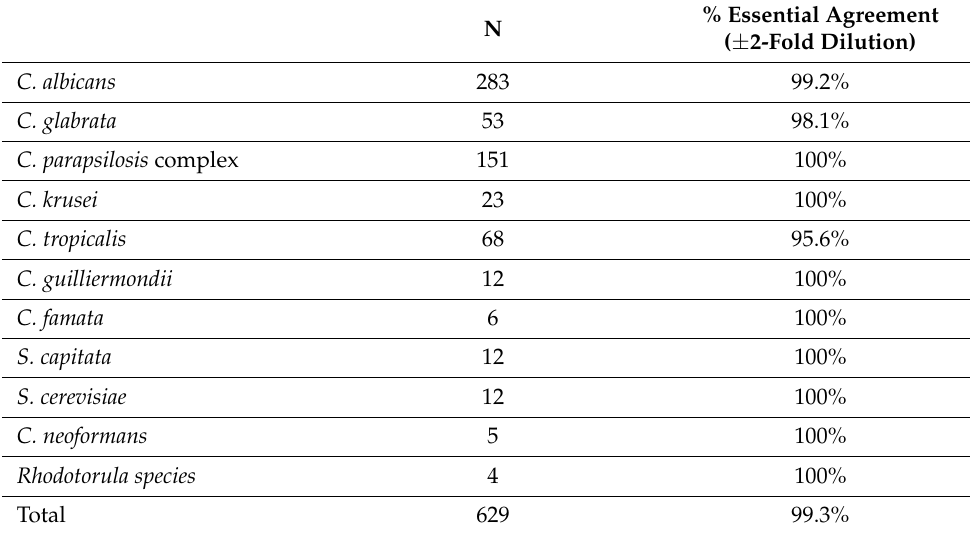
Table 2. Essential agreement between EUCAST broth method and MIC Strip method for the different yeast species involved in the